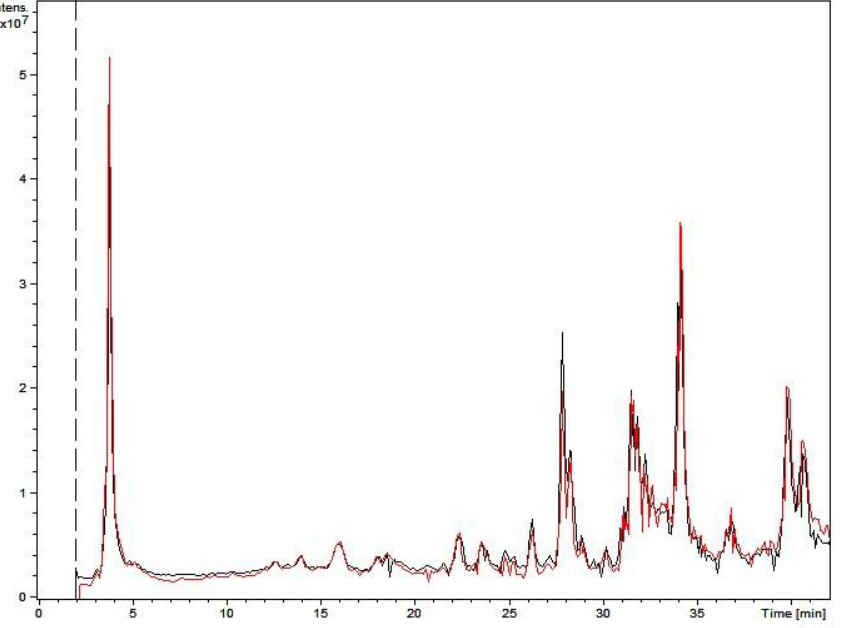
Figure 4. A comparison between samples of the same strain grown under the same conditions and extracted in acetonitrile.